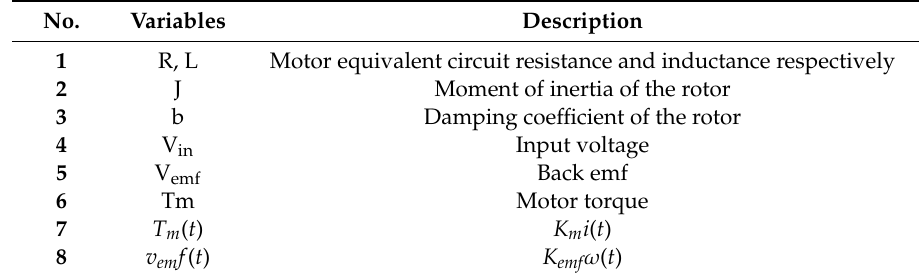
Table 1. Mathematical representation of the model.